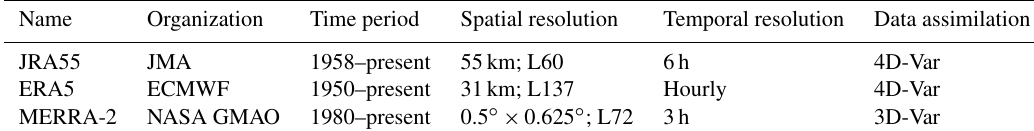
Table 1. Basic specifications of JRA55, ERA5, and MERRA-2 used in this study.